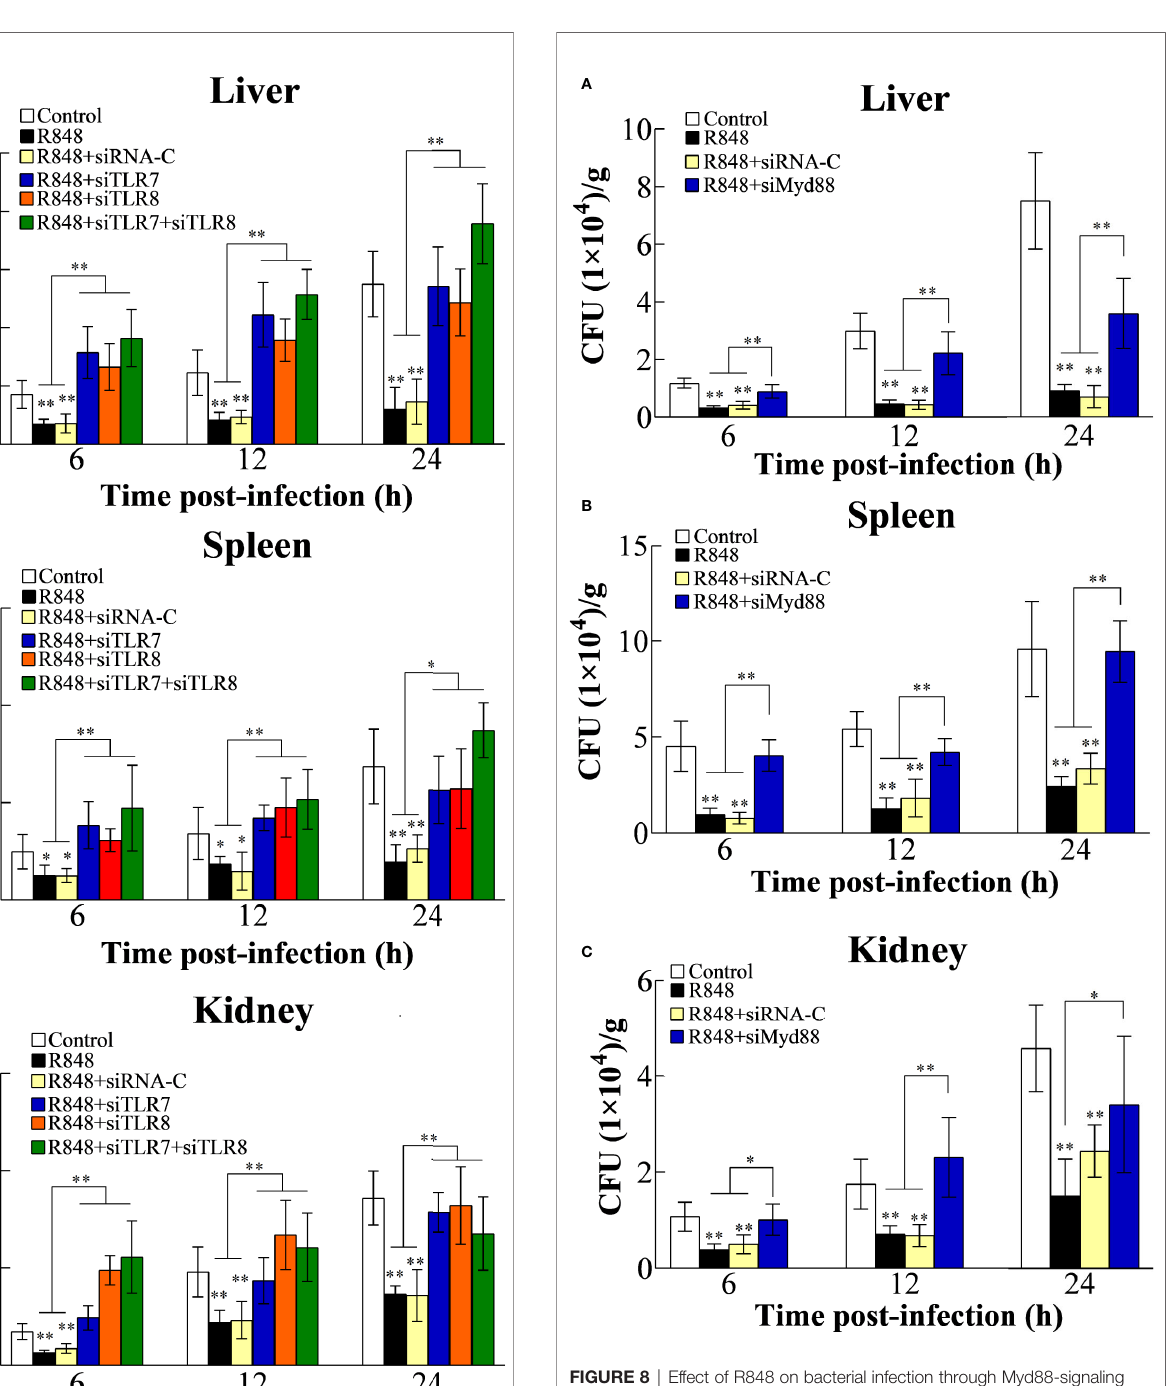
FIGURE 8 | Effect of R848 on bacterial infection through Myd88-signaling pathway. Golden pompano administered with R848, R848 plus siRNA-C, R848 plus siMyd88, or PBS (control) were infected with Edwardsiella tarda , and the amount of bacteria in the liver (A) , spleen (B) , and kidney (C) were determined at different time points. All data are shown as the means ± SD (N = 5), and the statistical signi fi cance is indicated. *P < 0.05, **P <